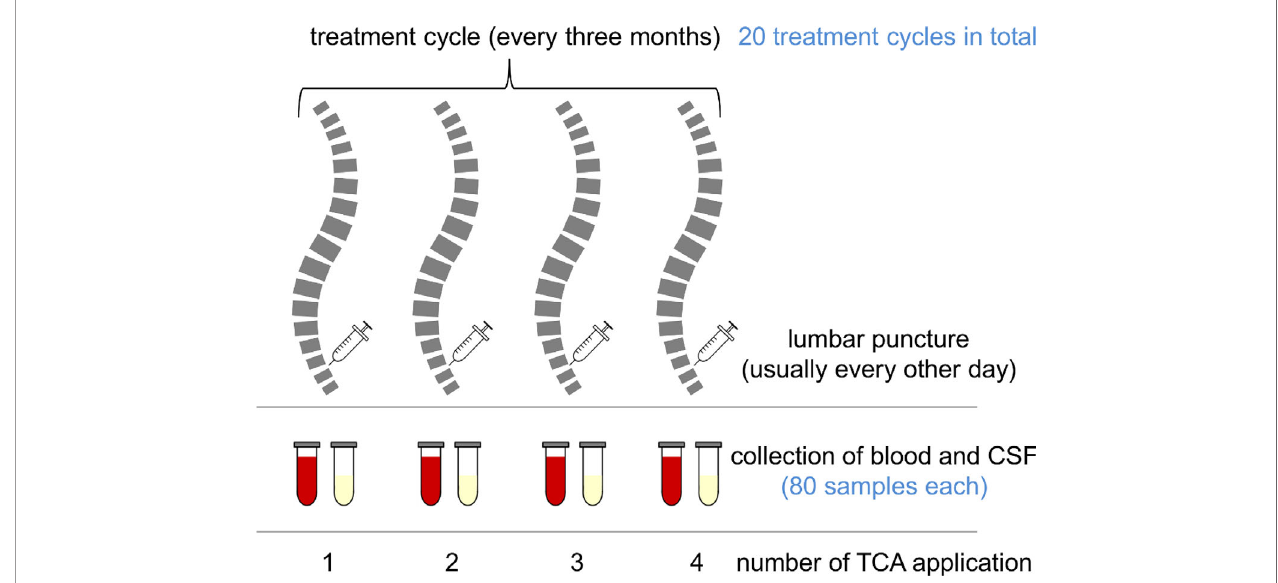
FIGURE 1 | Chart of a treatment cycle and sample collection. Multiple sclerosis (MS) patients suffering from spasticity were treated with intrathecal triamcinolone acetonide (TCA) every 3 months. Each treatment cycle consisted of four TCA applications (usually every other day). The patients were lumbar-punctured, and to avoid CSF pressure differentials, the CSF was drained and replaced with the same amount of TCA solution. After the procedure, peripheral blood was drawn for routine laboratory analyses. Remaining sample material was stored in a biobank at −